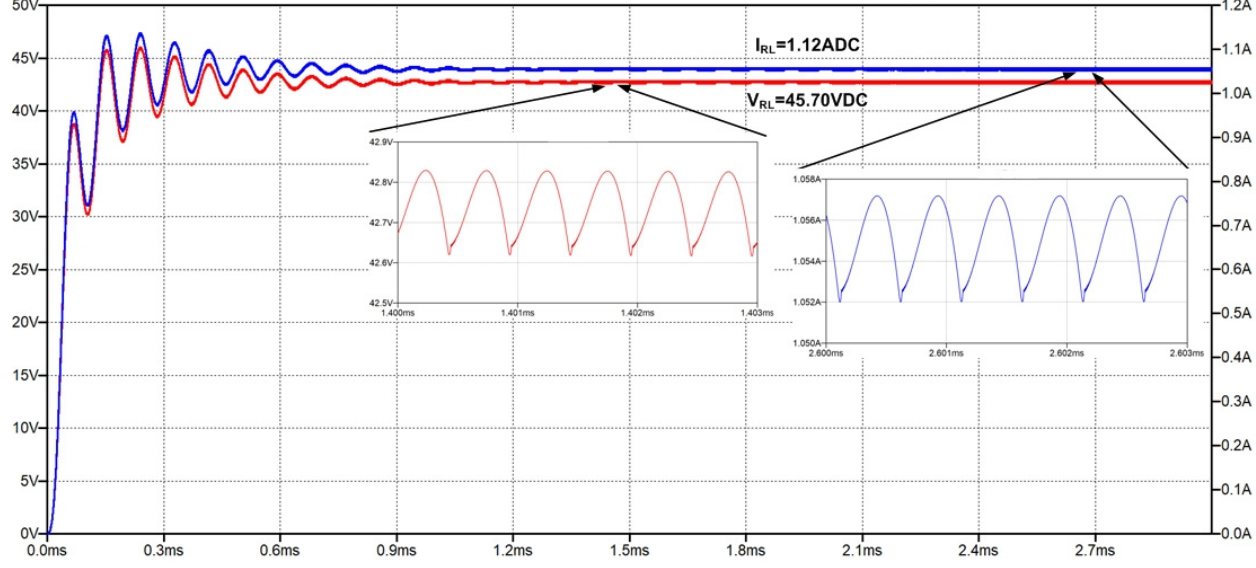
Figure 17. Voltage (red) and current (blue) waveforms at the load.